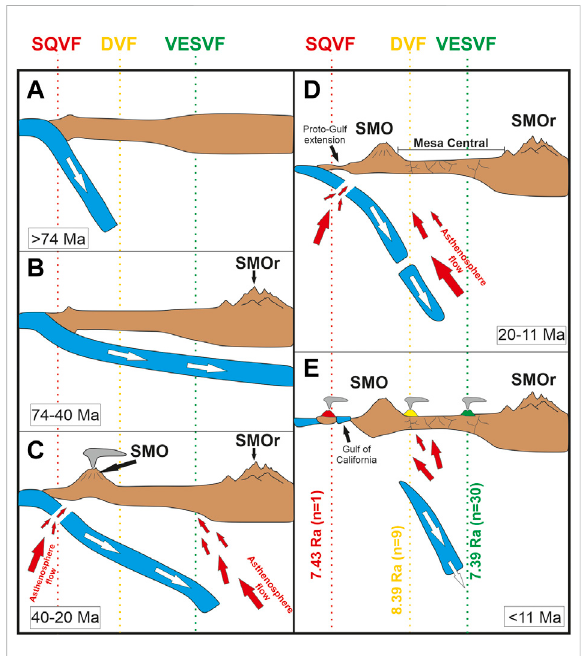
FIGURE 8 Evolution of the western margin of the North American plate during the Late Mesozoic and Cenozoic. (A) Subduction of the Farallon slab beneath North America during the Mesozoic. (B) Shallowing of the subduction angle and tectonic uplift of the Sierra Madre Oriental (SMOr; Laramide Orogeny). (C) Rollback and fi rst break-off of the Farallon slab causing the introduction of asthenospheric fl uids in the lithospheric mantle beneath the SQVF and VESVF. This process caused extensional deformation in the BasinandRangeProvince,refertilizationofthelithosphericmantle and the second ignimbrite fl are-up of the Sierra Madre Occidental (SMO). (D) Over time, the subduction angle increased and ceased triggering a second break-off episode and the subsequent proto- Gulfextension.SecondrefertilizationeventbeneathSQVF? (E) The lithospheric mantle beneath the DVF is fi nally refertilized. Subduction ends in the western margin of Mexico and the SCLM beneath SQVF, DVF, and VESVF evolves in steady-state becoming more radiogenic over time. The Basin and Range extension facilitated the formation of mantle xenolith-bearing alkali basalt localities (e.g., the VESVF, SQVF, and DVF) in the Mesa Central and the Baja California Peninsula. Adapted from Lee